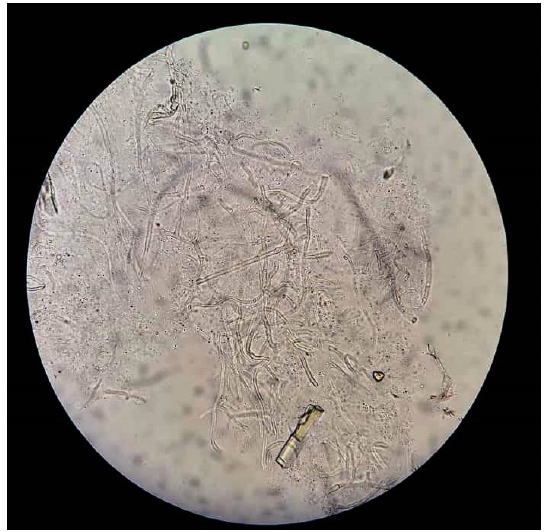
Figure 2. KOH mount of corneal scraping in a case of fungal keratitis showing the branching hyphae.